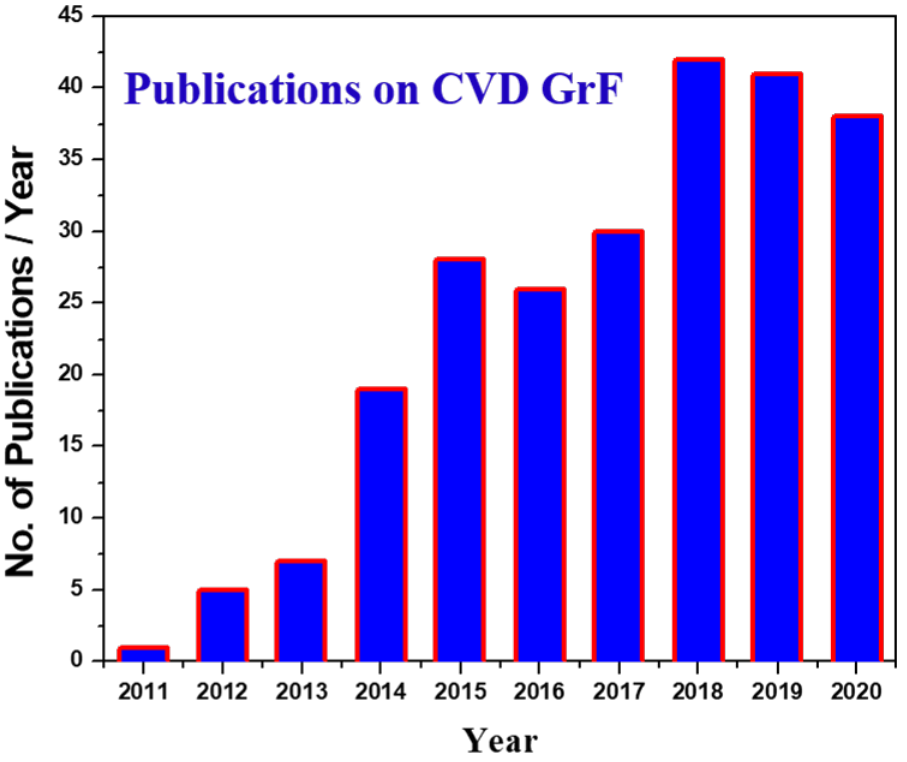
Figure 4. Data showing the number of scientific publications on GrF produced by chemical vapor disposition (CVD) since its advent in 2011 .